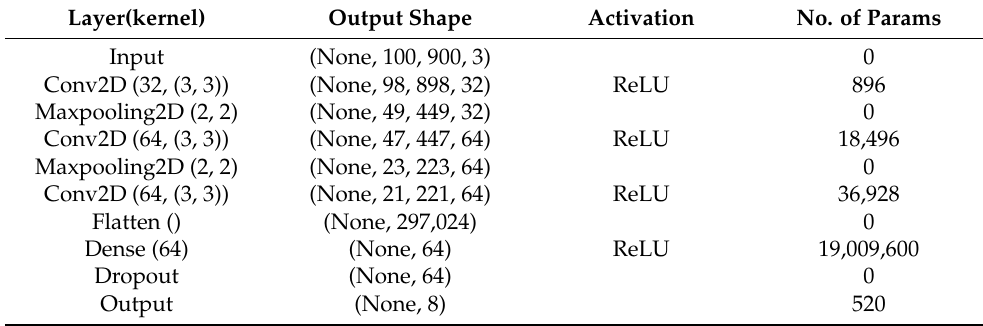
Table 1. The CNN model’s structure.